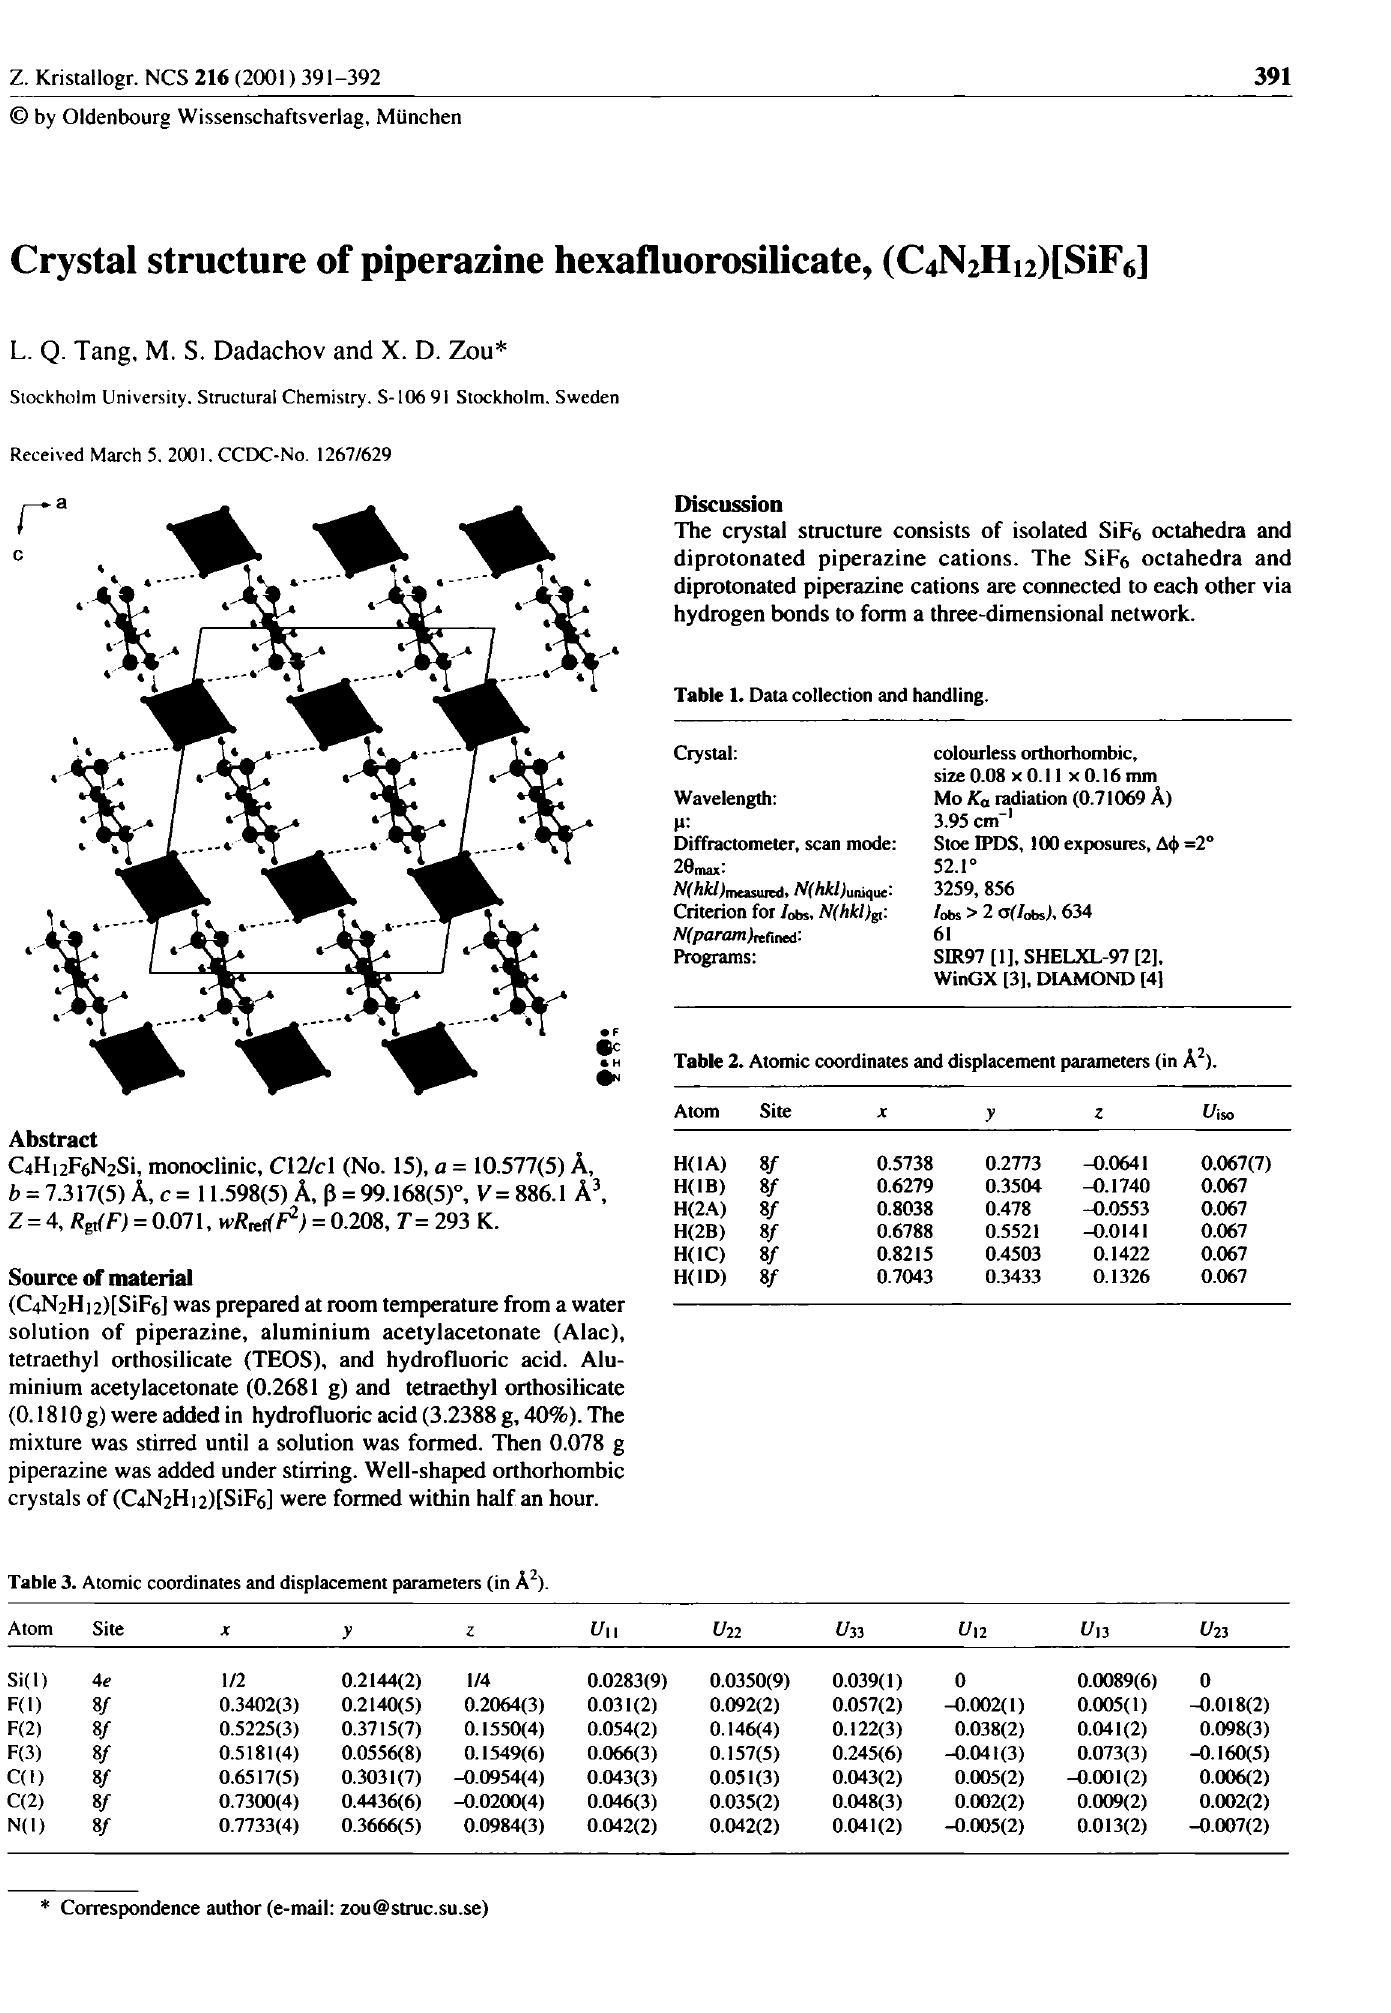
Table 1. Data collection and handling.